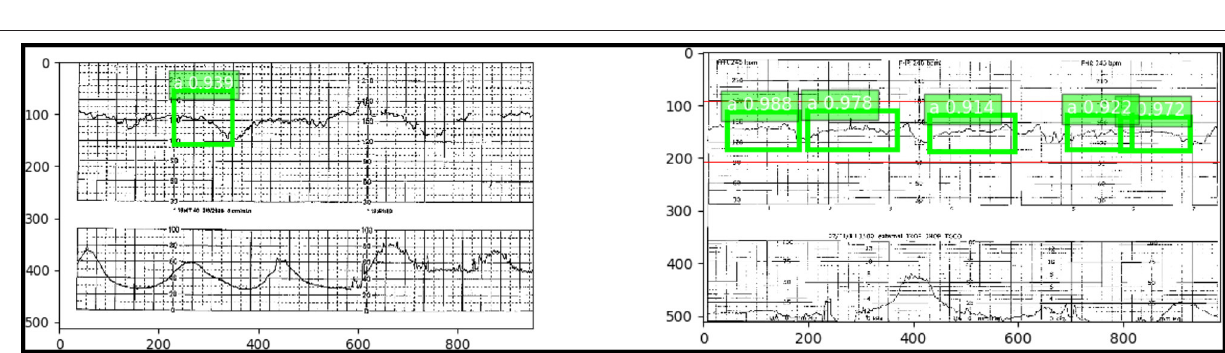
FIGURE 3 | (Left) “Point A” identified with a 93.6% accuracy using an SSD trained on the pdf chart images. (Right) Numerous occurrences of “Point A” with high confidence in green. Red indicates the true “Point A”